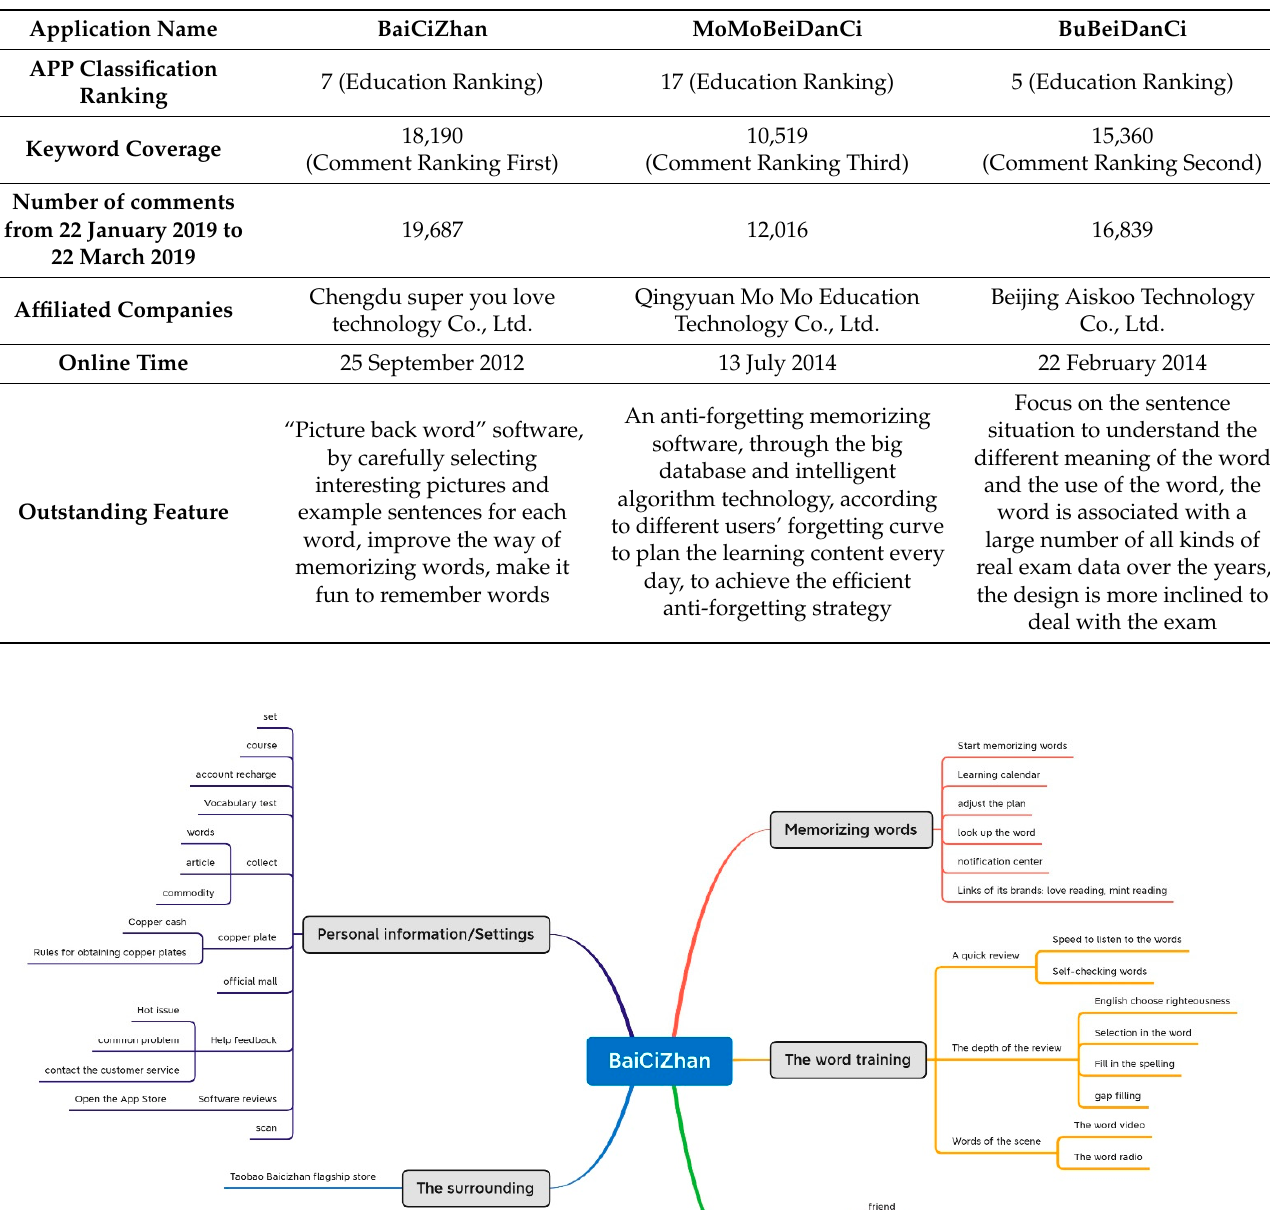
Table 1. Selected English Vocabulary APP information.